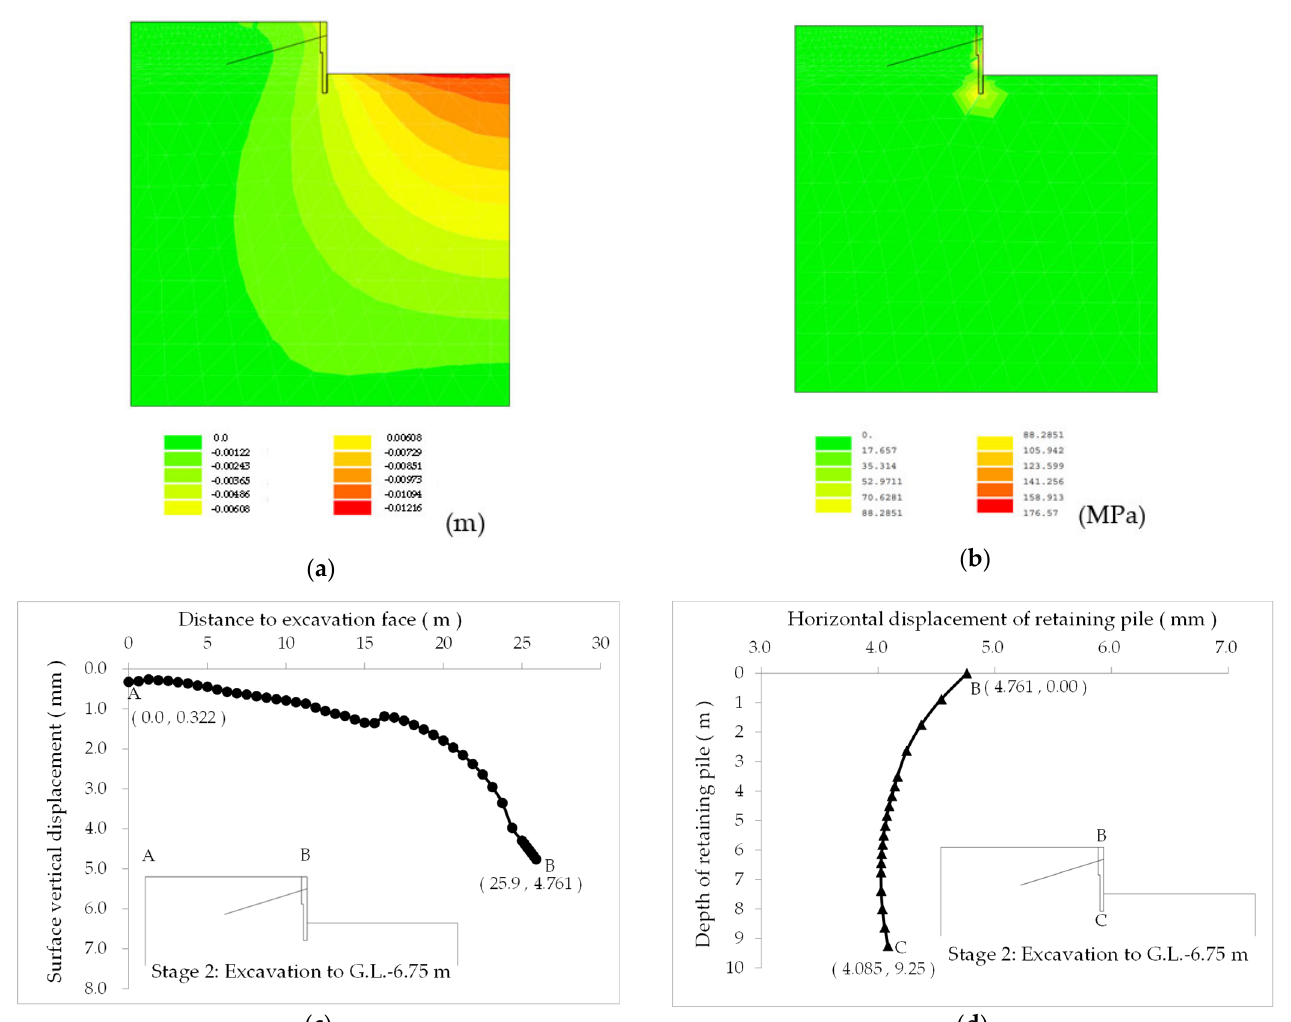
Figure 9. Results obtained with the 2D FEM analysis of the second ‐ stage excavation: ( a ) iso ‐ value of the total displacement; ( b ) iso ‐ value of the second deviatoric stress; ( c ) vertical surface displacement along the AB line; ( d ) horizontal displacement of the retaining pile along the BC line.